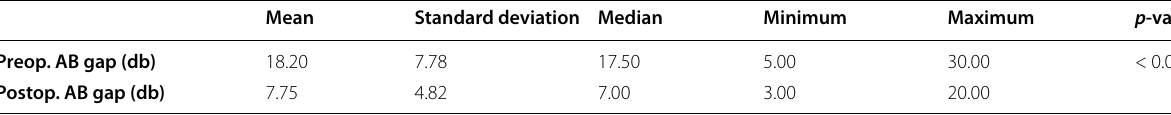
Table 2 Comparison of air-bone gap pre- and postoperative